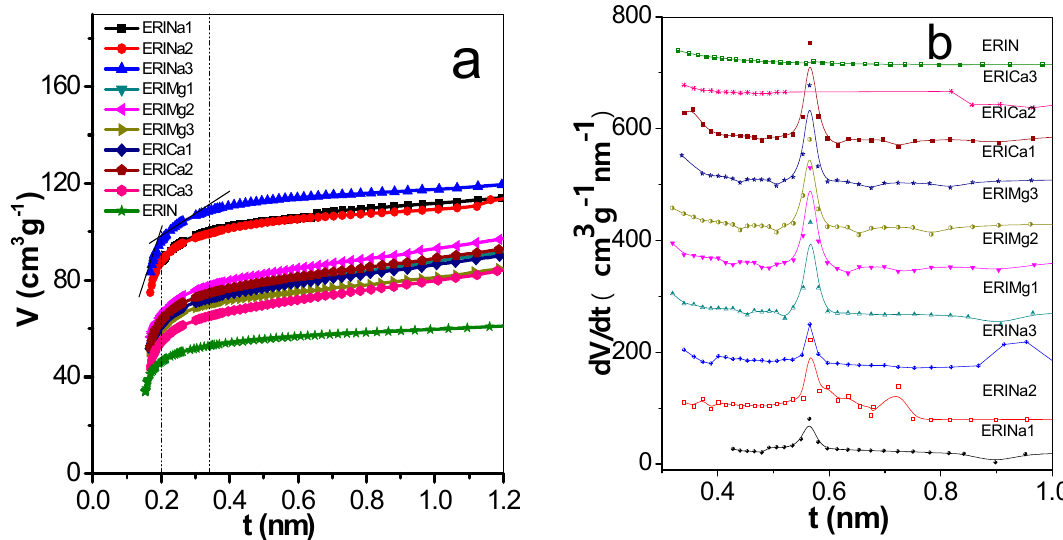
Figure 4. ( a ) t-plots and ( b ) pore size distribution by differential curves of adsorption of erionite zeolites.